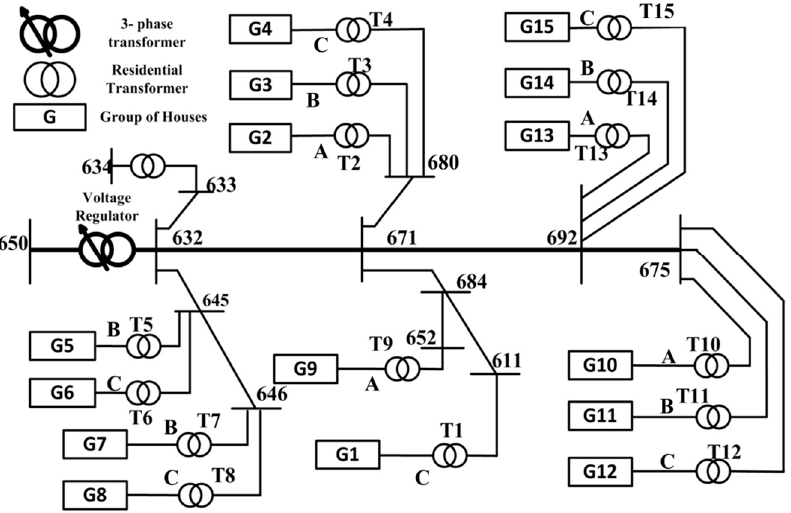
Figure 3. Residential distribution grid for impact study.